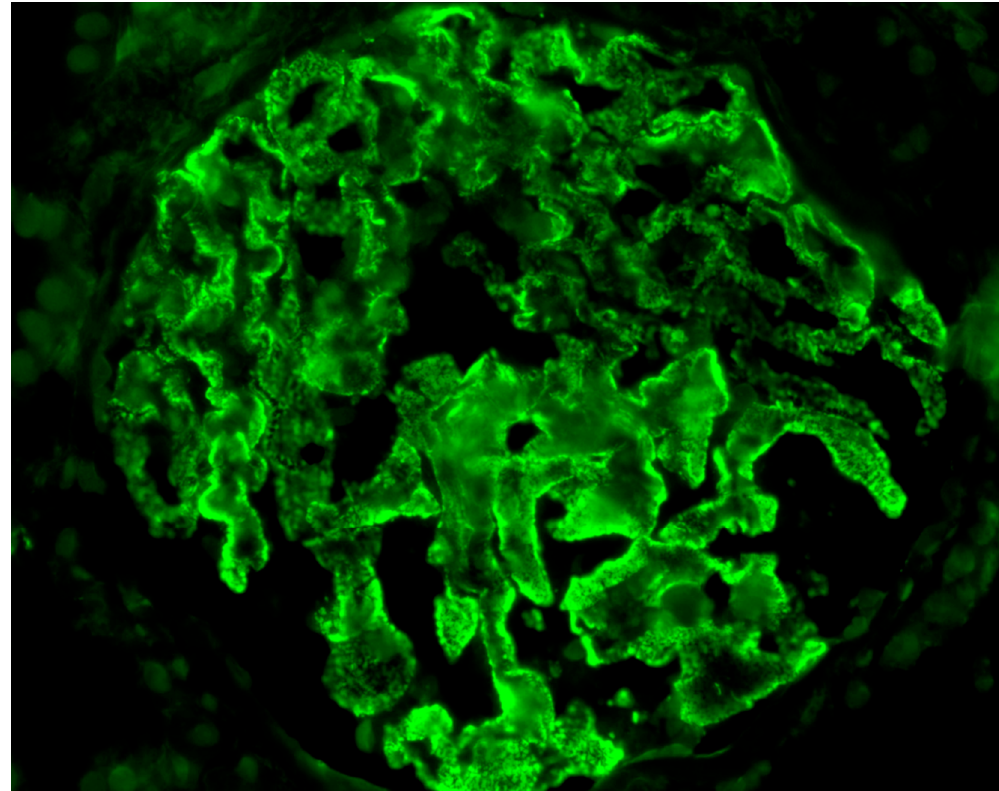
Figure 3. Immunofluorescence image of a kidney biopsy (patient #7, Table 2) showing IgG staining along the glomerular capillary wall, diagnostic of a membranous nephropathy (IgG × 400).